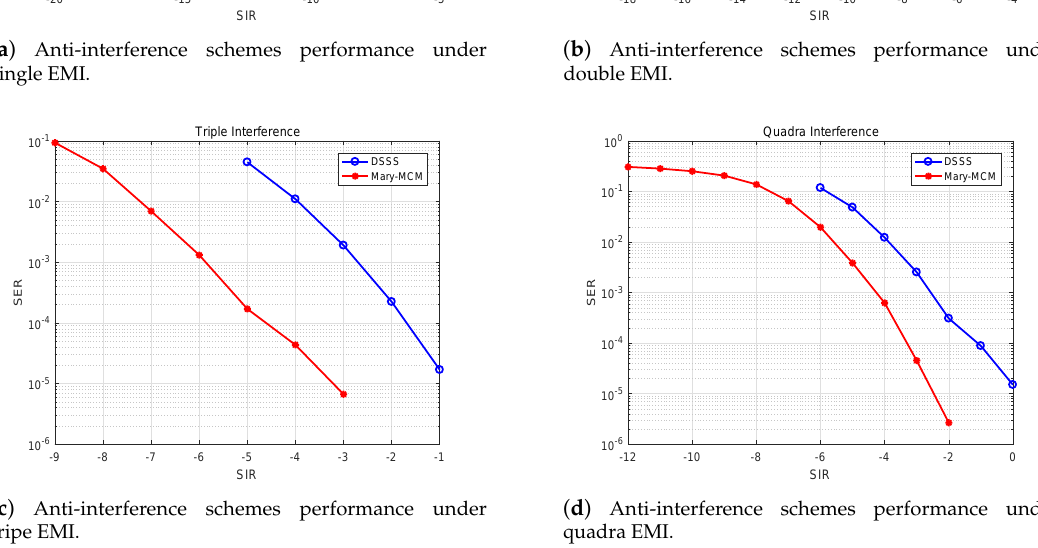
Figure 17. Anti-interference schemes performance under different EMI